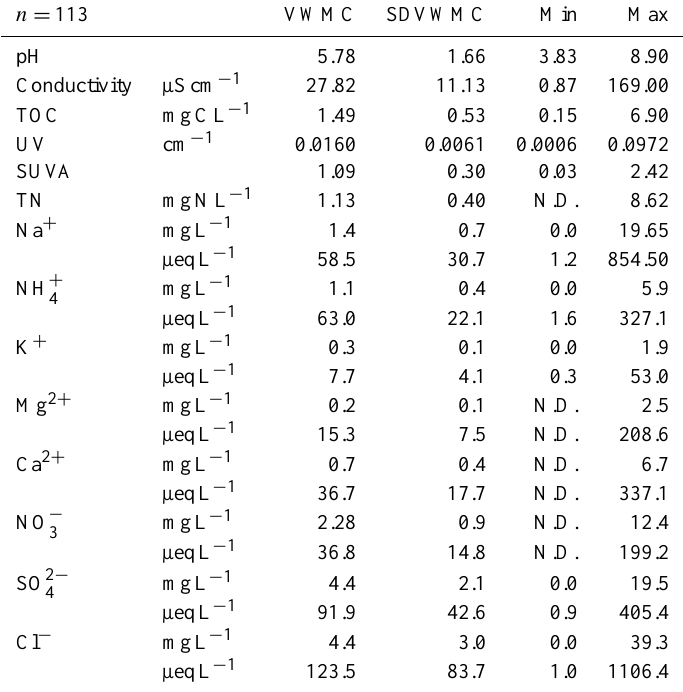
Table 1. Volume-weighted mean concentration (VWMC), standard deviation of the VWMC (SDVWMC), and minimum (Min) and maxi- mum (Max) concentrations of chemical composition in rainwater collected from June to December during 2012. n = 113